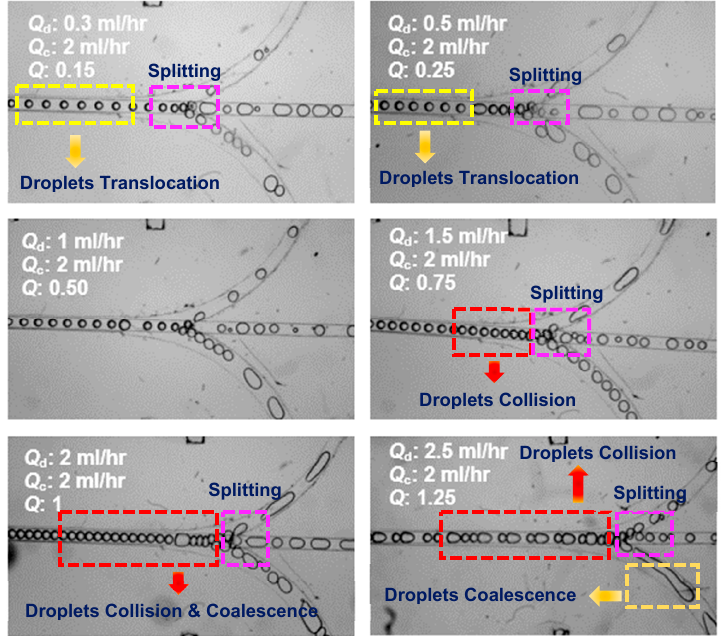
Figure 18. Droplet collision and coalescence phenomena in asymmetrical splitting junctions at different flow rate ratio (0.15 < Q < 1.25) by fixing the Q c and varying the Q d . As compared to symmetrical splitting systems, the values for analytical coefficient of variation (CV%) given in Table 2 show better performance. CV% of less than 3% found at the T-junction indicates the formation of monodispersed droplet which can be observed similarly in the counterpart symmetrical splitting systems. Moreover, overall values of CV% obtained at the downstream splitting were found to be lower than the symmetrical splitting system. For instance, CV% value of about 25%